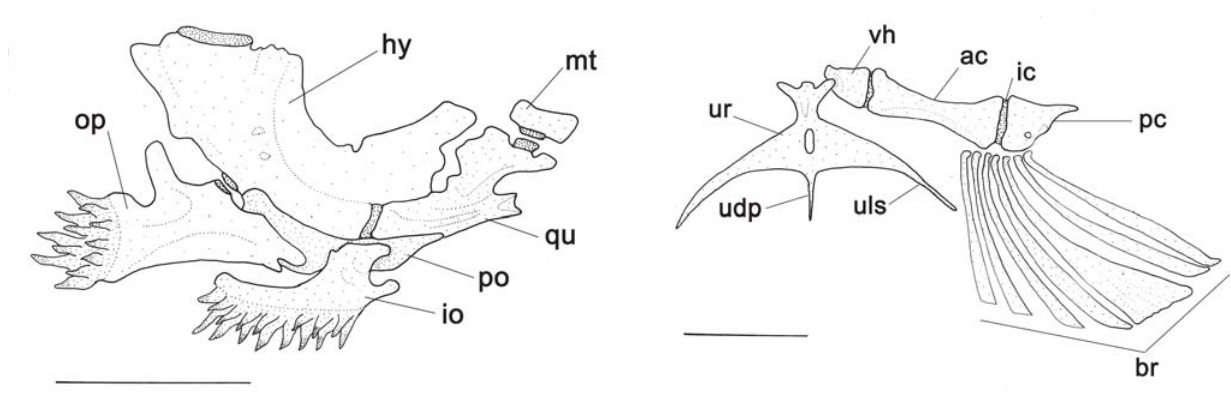
Fig. 3. Right suspensorium of Ituglanis cahyensis , MNRJ 28405, paratype, 41.3 mm SL. Lateral view. Abbreviations: hy, hyomandibula; io, interopercle; mt, metapterygoid; op, opercle; po, preopercle; qu, quadrate. Scale bar = 1.5 mm.